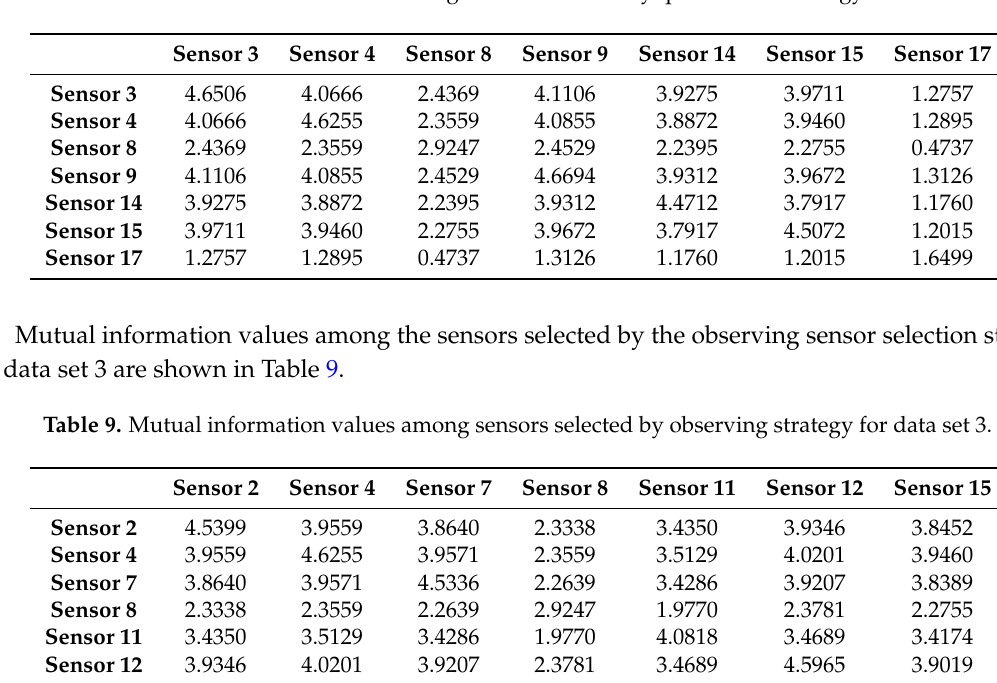
Table 8. Mutual information values among sensors selected by quantitative strategy for data set 3.